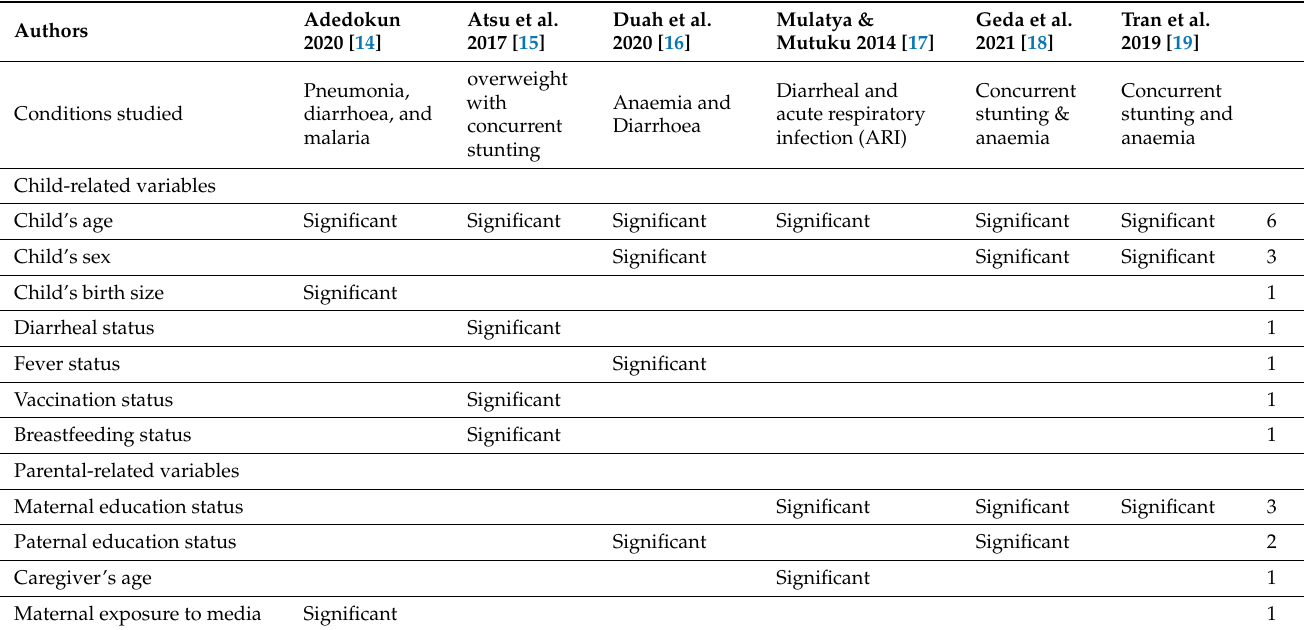
Table 5. Distribution of common risk factors across the